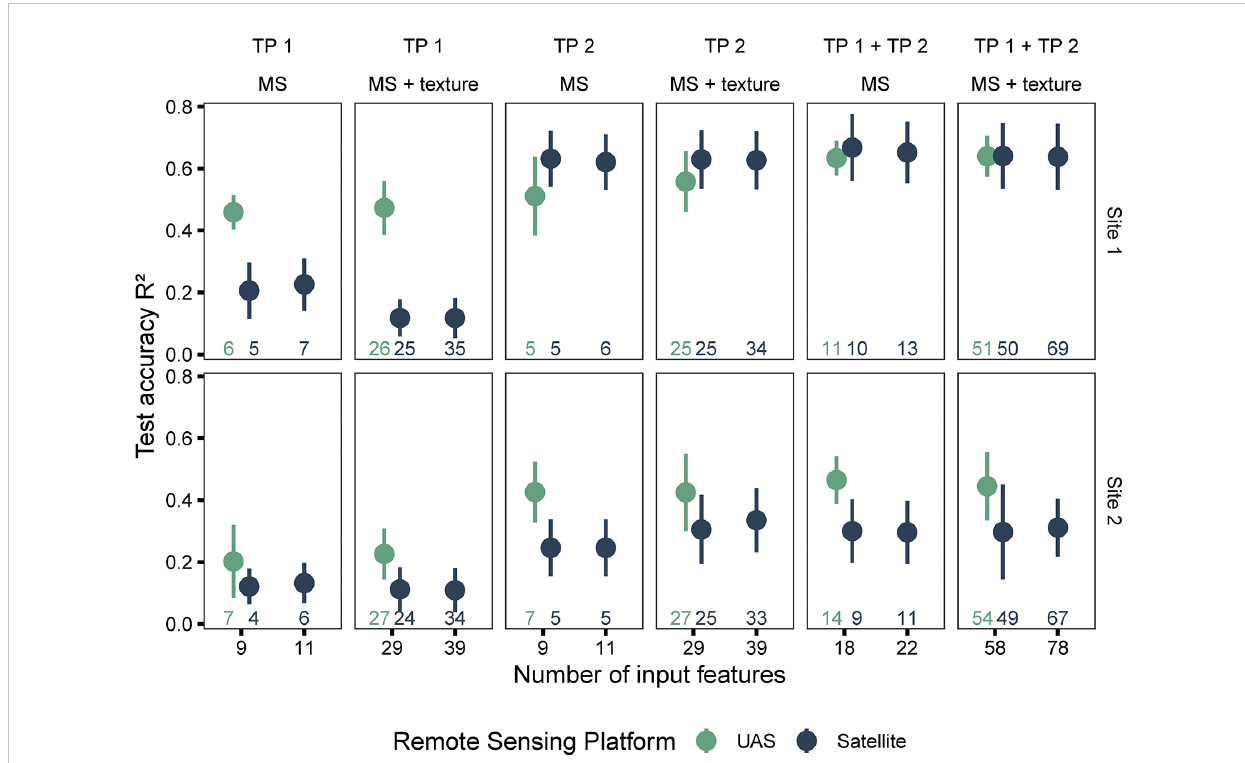
FIGURE 5 Model performance based on data source (satellite and UAS), type of features used in model (spectral and spectral + texture), and time points (individual and combined time points). The number of input features represented as labels of the x-axis indicates the number of features before the correlation fi lter. The colored numbers above the x-axis represent the total number of features retained after the correlation fi lter, which were used to build the random forest models.